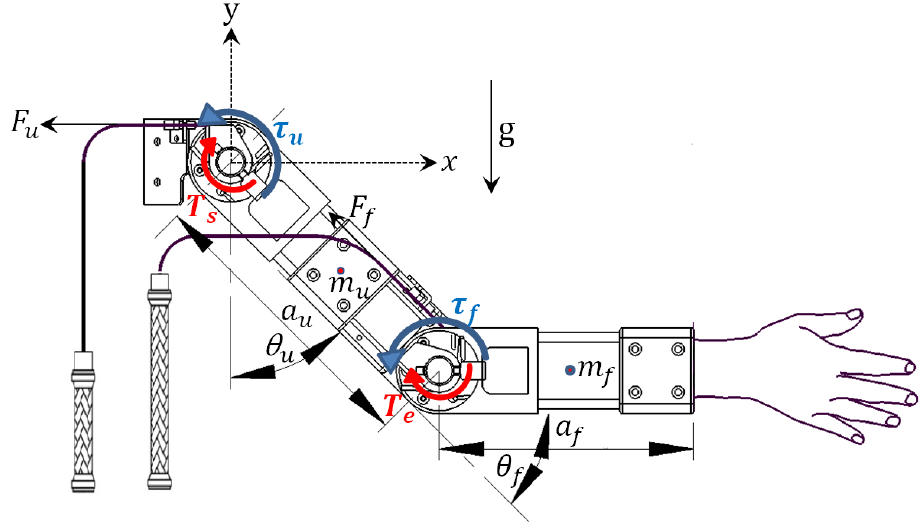
Figure 8. Unilateral arm of the designed WURAES.